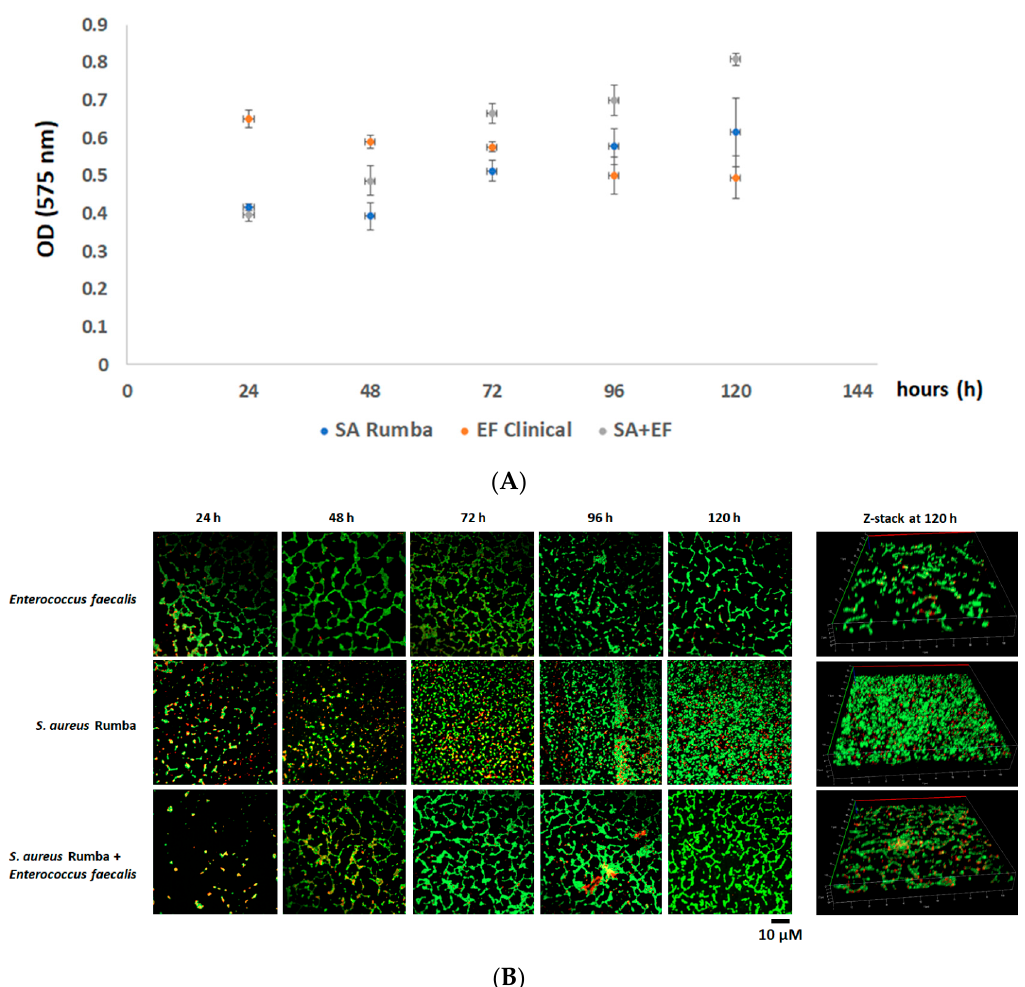
Figure 4. The formation of biofilm by E. faecalis clinical isolate and S. aureus Rumba. ( A ) Crystal violet staining to measure the thickness of the mono and dual biofilms formed by E. faecalis clinical isolate and S. aureus Rumba. The thickest biofilm was formed by the dual biofilm at the end of 120 h of growth. ( B ) Microscopy image of biofilm-embedded cells. Green shows live cells and red shows dead cells. The three-dimensional image of biofilm at the end of 120 h is shown as z-stack. The experiment was performed in triplicate, and error bars show the standard deviation.